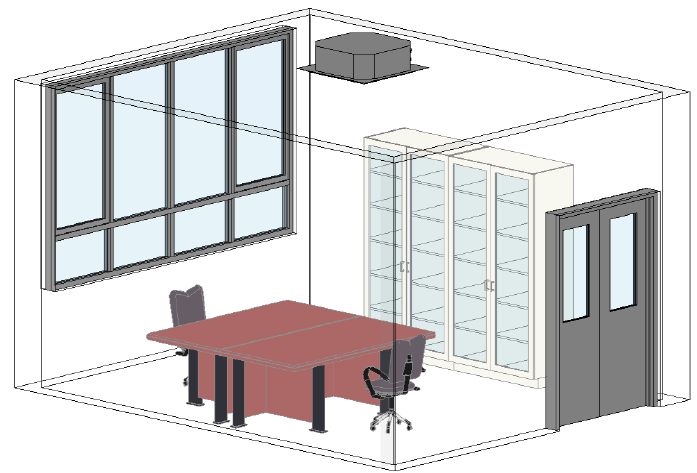
Figure 4. The layout of the studied office room.